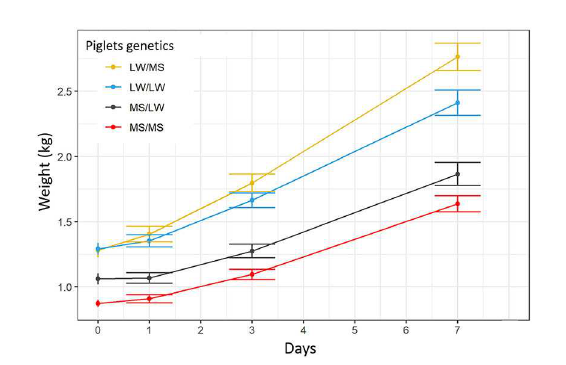
FIGURE7 Growth curves for the four piglet genetic types (dam breed/sire breed).